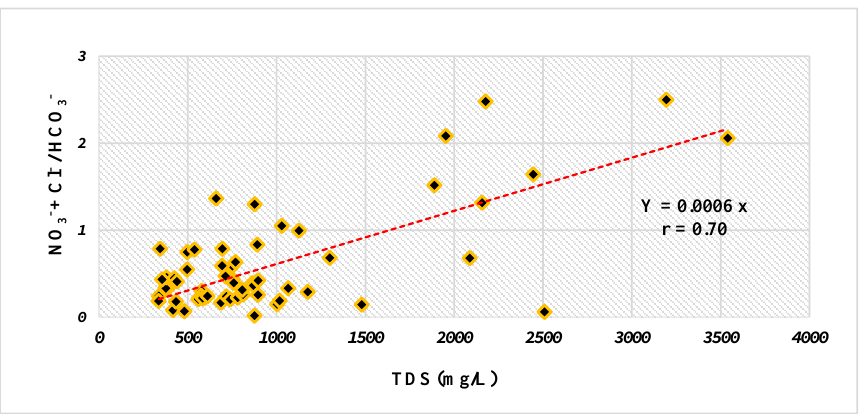
Figure 4. Bivariate plot to check the relation between TDS and NO 3 − + Cl − /HCO 3 − .